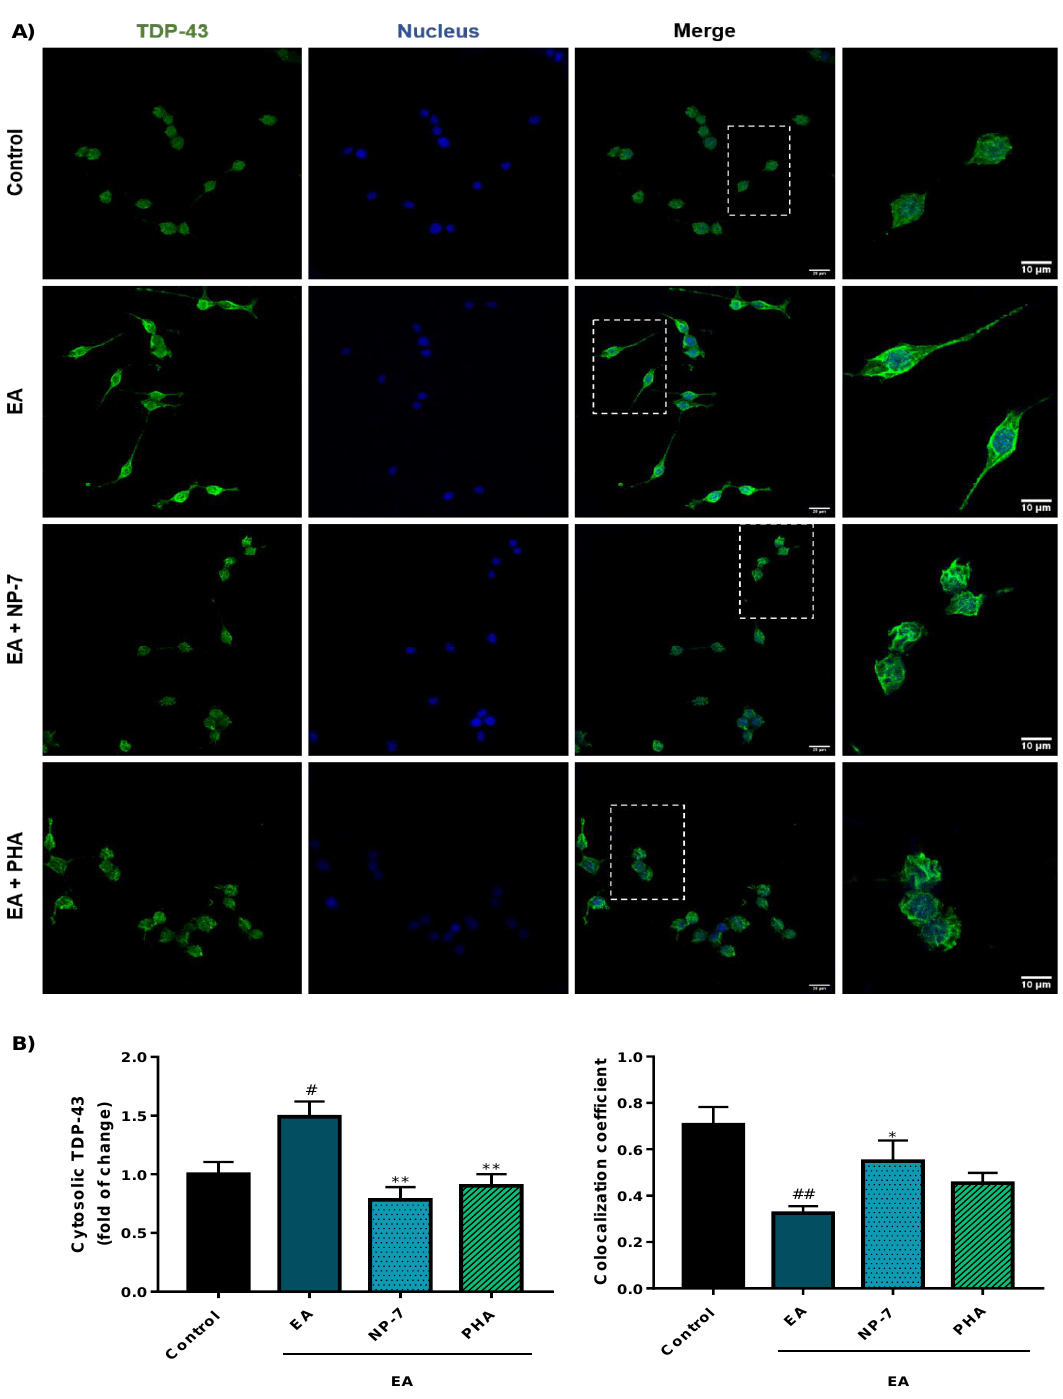
Figure 8. Immunofluorescence analysis of the subcellular localization of TDP-43 in SH-SY5Y cells exposed to EA after PHA and NP-7 treatment. ( A) Cells were pre-treated with PHA (0.5 µ M) or NP-7 (0.5 µ M) and exposed to EA (40 µ M). NP-7 concentration was calculated, referring to encapsulated PHA, so cells were exposed to the same amount of PHA. TDP-43 localization was assessed by confocal laser scanning microscopy. Scale bar: 10 µM and 20 µM. ( B ) Quantification of cytosolic TDP-43 (right) and colocalization analysis by calculating Mander’s colocalization coefficient which indicates the percentage of total TDP-43 inside the nucleus (left). At least 50 different cells from 3 separate wells ( n = 3) were analyzed. Data represent the mean ± SEM (magnification 63×). (* p < 0.05, ** p < 0.005 significantly different from SH-SY5Y EA-treated cells, # p < 0.05, ## p < 0.005 significantly different from control).